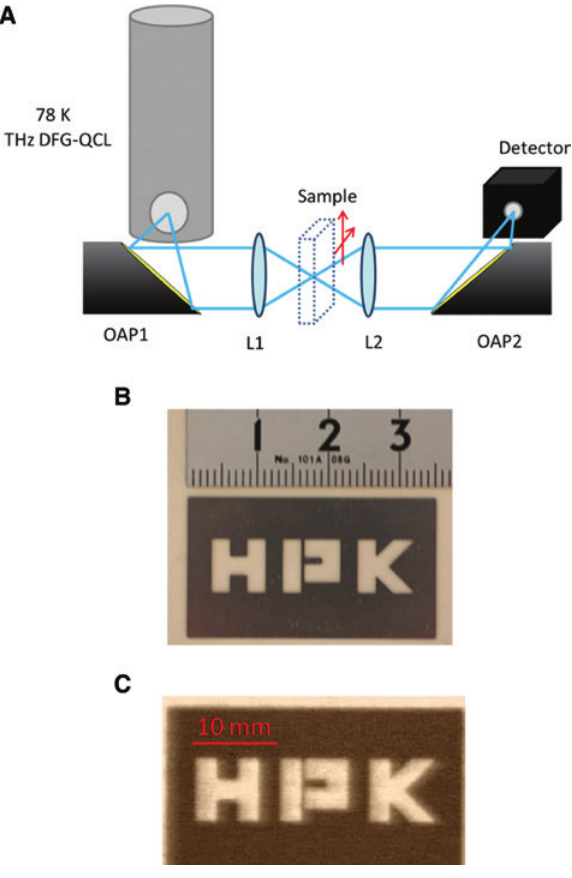
Figure 21: Terahertz imaging of the DFG-QCL. (A) Schematic diagram of terahertz imaging system using a THz DFG-QCL operated at 78 K. (B) Photograph of stainless-steel plate with openings in the shape of the letters “HPK”. (C) Terahertz image of the stainless plate in paper envelope with THz